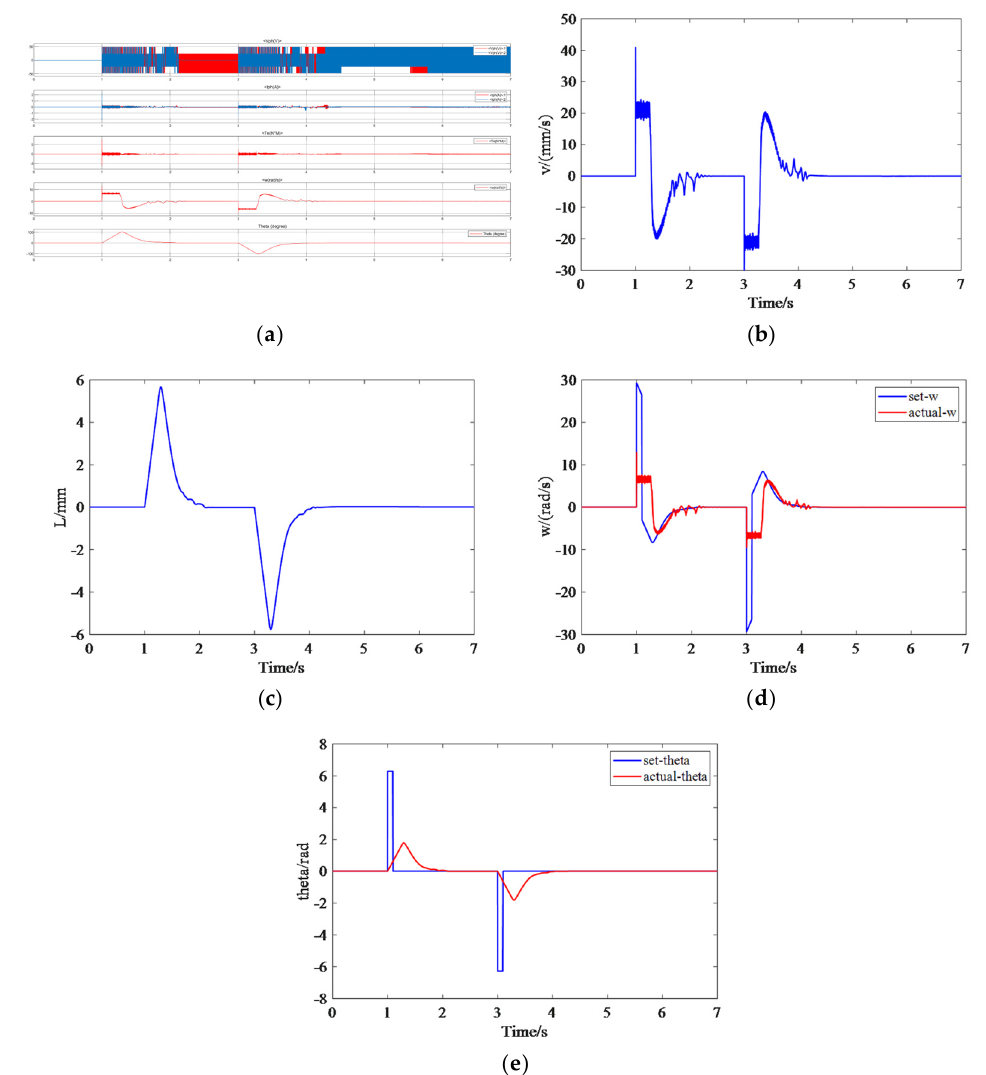
Figure 10. The simulation results of stepper motor with abrupt climbing in smooth condition based on incremental PID control strategy for automatic control system of cutter height off the ground. ( a ) The simulation results of stepper motor voltage, current, electromagnetic torque, rotation speed, and rotation angle with abrupt climbing in smooth condition based on incremental PID control strategy for automatic control system of cutter height off the ground; ( b ) the simulation results of stepper motor rotation speed (mm/s) with abrupt climbing in smooth condition based on incremental PID control strategy for automatic control system of cutter height off the ground when the pitch of ball screw device is 20 mm; ( c ) the simulation results of stepper motor rotation distance (mm) with abrupt climbing in smooth condition based on incremental PID control strategy for automatic control system of cutter height off the ground when the pitch of ball screw device is 20 mm; ( d ) the simulation results of stepper motor setting rotation speed and actual rotation speed with abrupt climbing in smooth condition based on incremental PID control strategy for automatic control system of cutter height off the ground; ( e ) the simulation results of stepper motor setting rotation angle and actual rotation angle with abrupt climbing in smooth condition based on incremental PID control strategy for automatic control system of cutter height off the